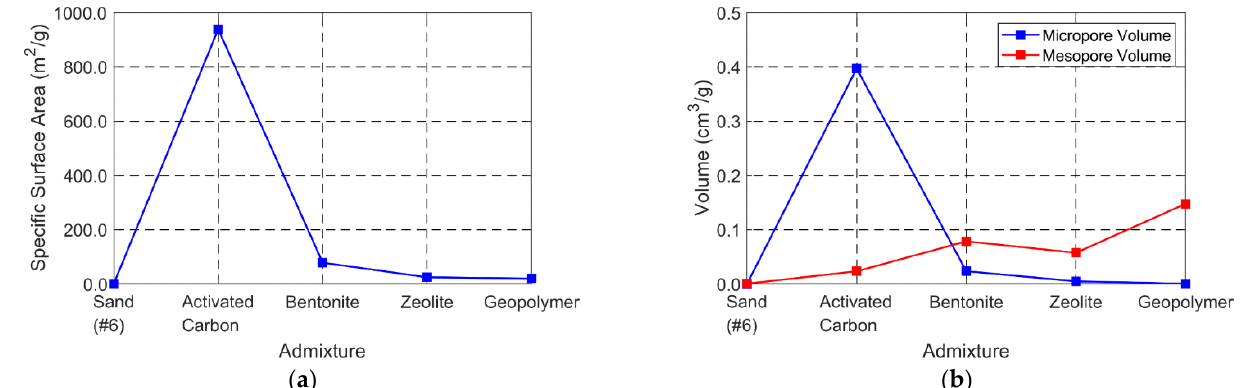
Figure 2. Specific surface area ( a ) and micropore and mesopore volumes ( b ) of admixtures and sand.